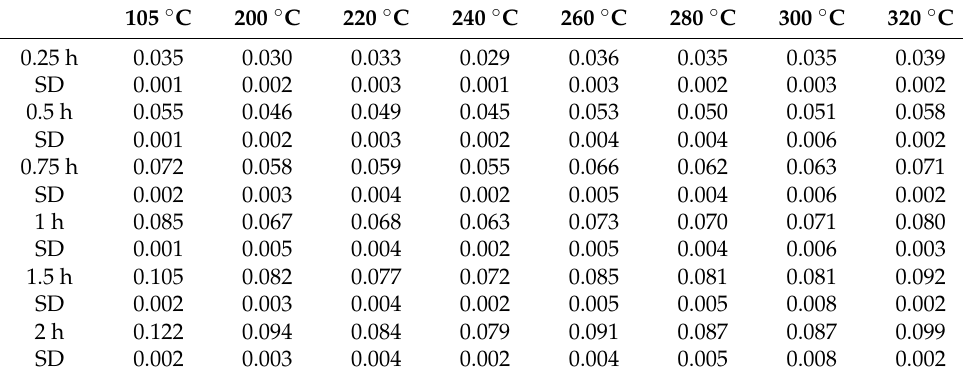
Table 4. Influence of the climatic chamber operation time (CCOT) and the torrefaction temperature on the value of the EMC coefficient for grapefruit